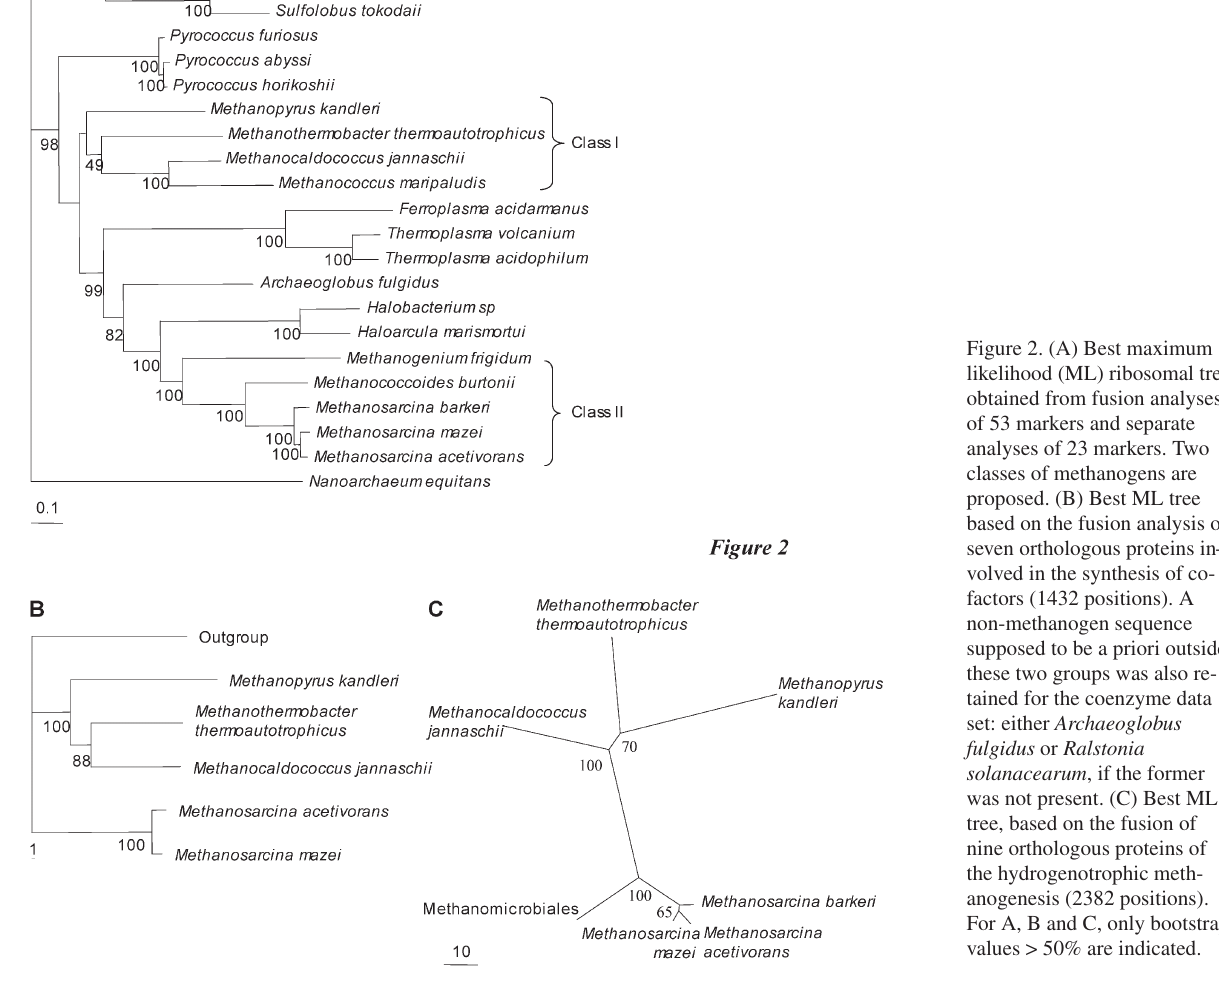
Figure 2. (A) Best maximum likelihood (ML) ribosomal tree obtained from fusion analyses of 53 markers and separate analyses of 23 markers. Two classes of methanogens are proposed. (B) Best ML tree based on the fusion analysis of seven orthologous proteins in- volved in the synthesis of co- factors (1432 positions). A non-methanogen sequence supposed to be a priori outside these two groups was also re- tained for the coenzyme data set: either Archaeoglobus fulgidus or Ralstonia solanacearum , if the former was not present. (C) Best ML tree, based on the fusion of nine orthologous proteins of the hydrogenotrophic meth- anogenesis (2382 positions). For A, B and C, only bootstrap values > 50% are